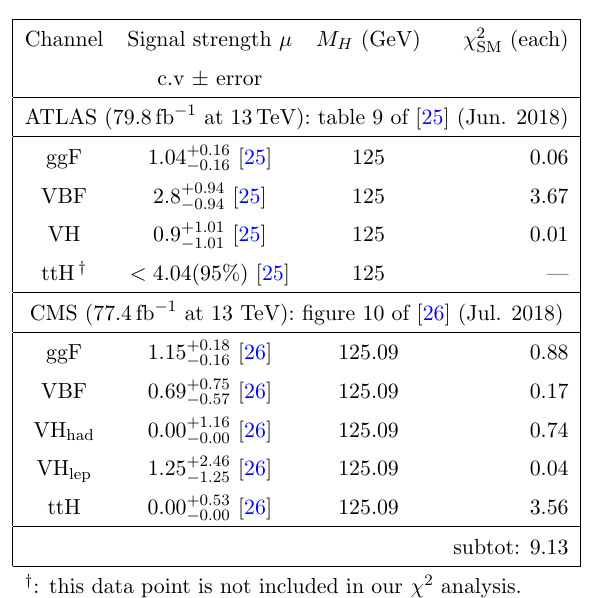
Table 10 . (LHC: 13 TeV) The same as table 9 but for H ! ZZ ( (cid:3) ) .